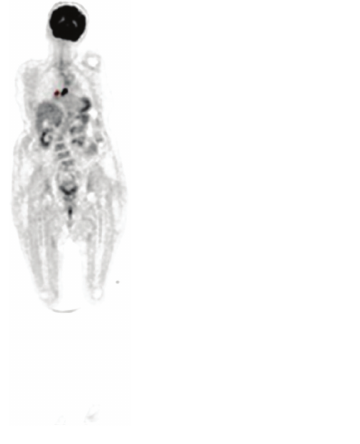
Figure 4: Positron emission tomography demonstrated a primary focus in